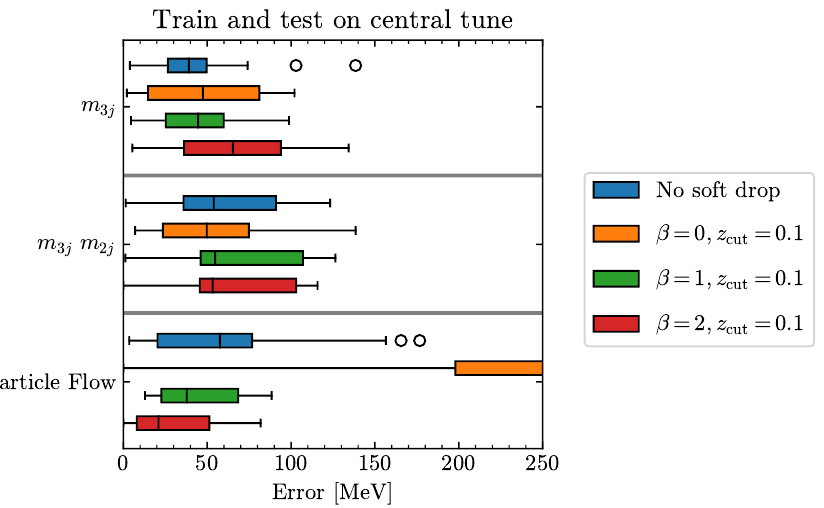
Figure 11. Errors on the mass of the top quark returned by the DCTR methods when trained and tested only on the central tune, for different soft drop parameters. Adding extra information (such as the mass of the W jet) does not seem to increase the accuracy. The uncertainty for the method is on the order of 50